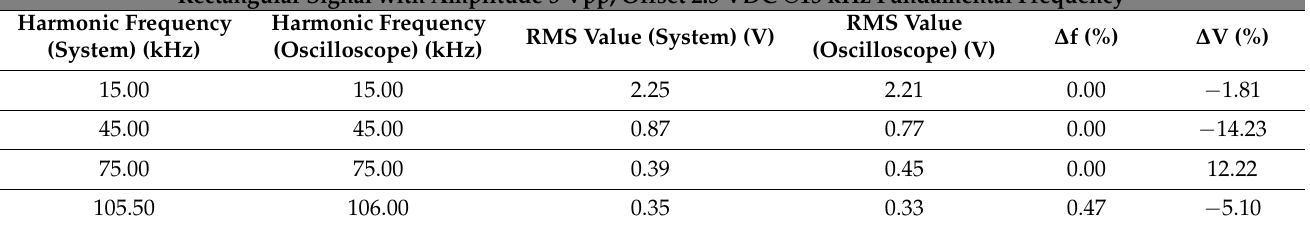
Table 4. Comparisons between the calibrated oscilloscope and the FPGA-based system measurements for rectangular signal with amplitude of 5 Vpp with 2.5 VDC offset value, for a signal’s fundamental frequency at 15 kHz.